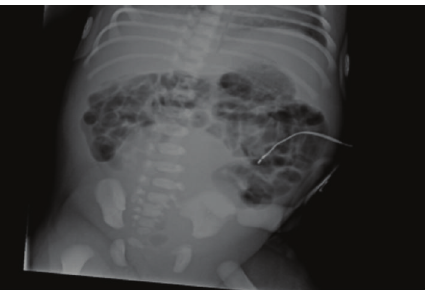
Figure 2: Plain abdominal radiograph of Neonate B showing infraumbilical midline abdominal opaque mass.